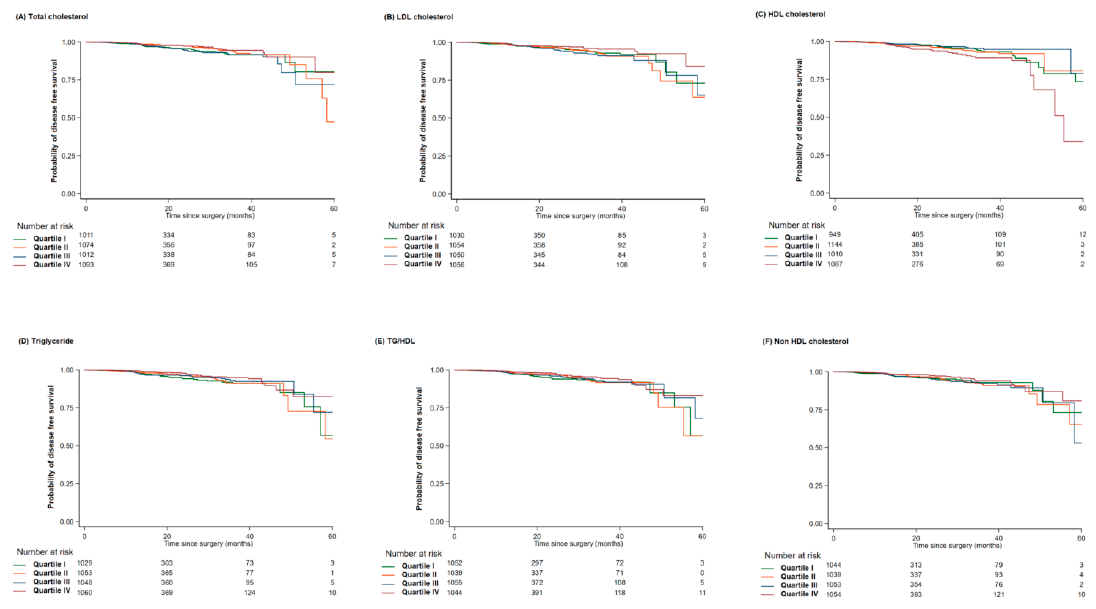
Figure 4. Hazard ratio by each lipid exam score. HDL: high density lipoprotein; LDL: low density lipoprotein; TG: total cholesterol.